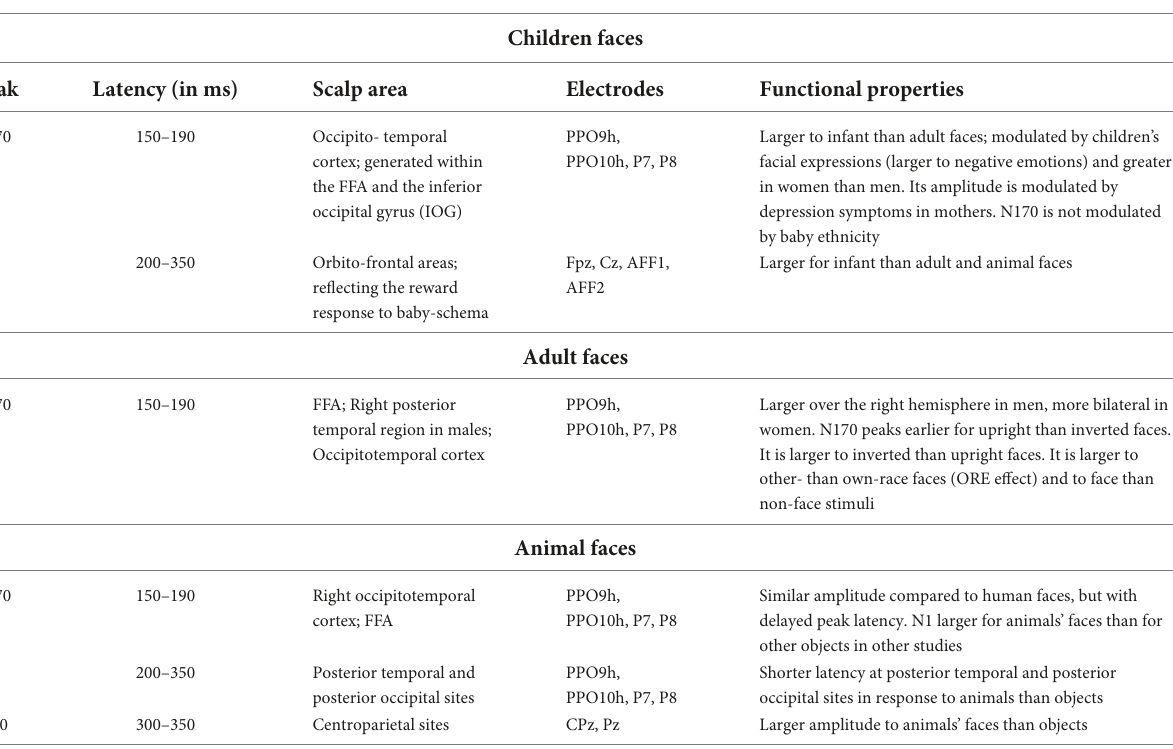
TABLE 1 Functional properties of N170 and other face-specific responses of visual ERPs to infant, adult, and animal faces, according to psychophysiological literature (Bentin et al., 1996; Kanwisher et al., 1997; Haxby et al., 2000; Rossion and Gauthier, 2002; Rousselet et al., 2004; Proverbio et al., 2006, 2007, 2020b; Sadeh and Yovel, 2010; Noll et al., 2012; Rossion, 2014; Wiese et al., 2014; Jacques et al., 2019; Proverbio, 2021).